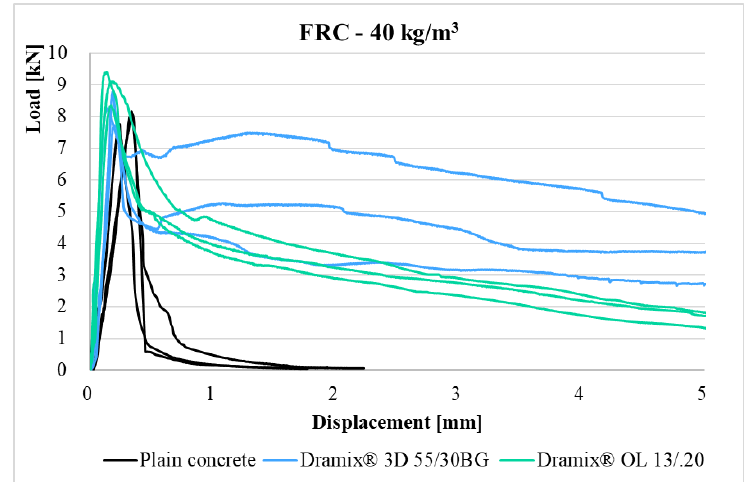
Figure 13. Load–displacement diagrams for plain concrete and fiber-reinforced concrete with fiber dosage of 40 kg/m 3 .